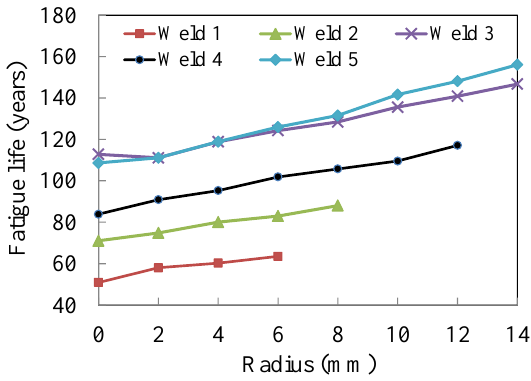
Figure 24. Variation of fatigue life with grinding radius.